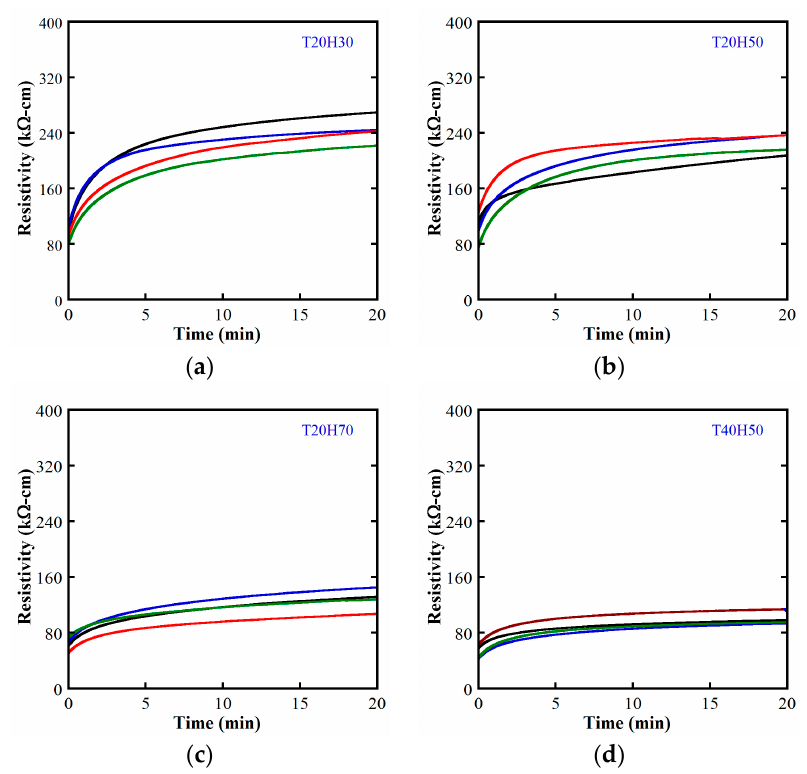
Figure 11. Electrical resistivity responses of MSFRC under different environmental conditions: ( a ) at temperature 20 °C, humidity 30%; ( b ) at temperature 20 °C, humidity 50%; ( c ) at temperature 20 °C, humidity 70%; ( d ) at temperature 40 °C, humidity 50%.